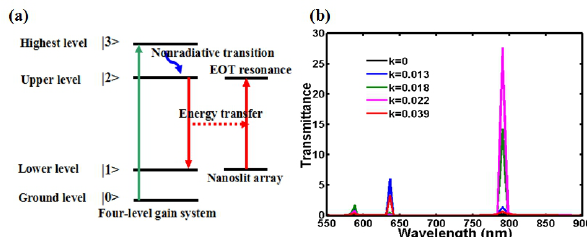
Fig. 5. (a) Schematic of the energy transfer from an optically excited four-level gain medium to the EOT resonance of the nanoslit array. (b) The transmission spectra of nanoslit array with different values of optical